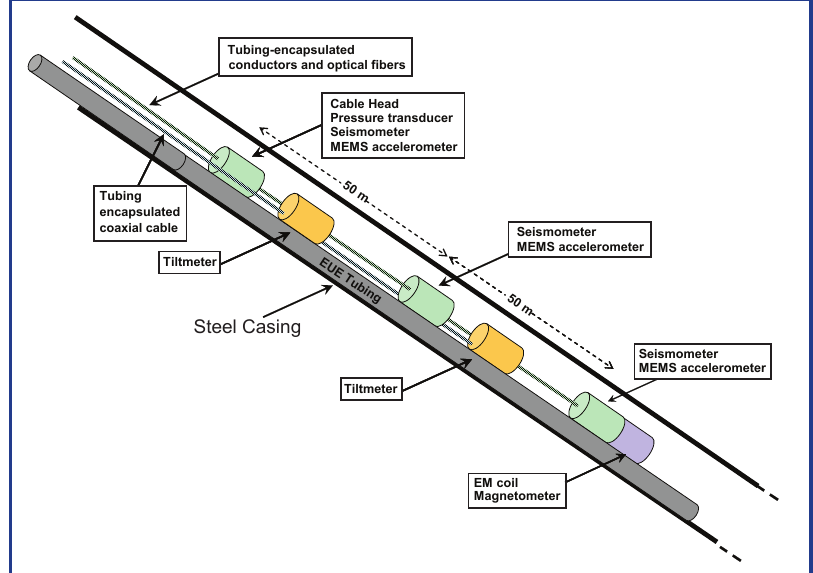
Figure 7. Schematic diagram of the instrumentation deployed in the SAFOD observatory above the location of the HI repeating earthquake sequence (see Fig. 5).